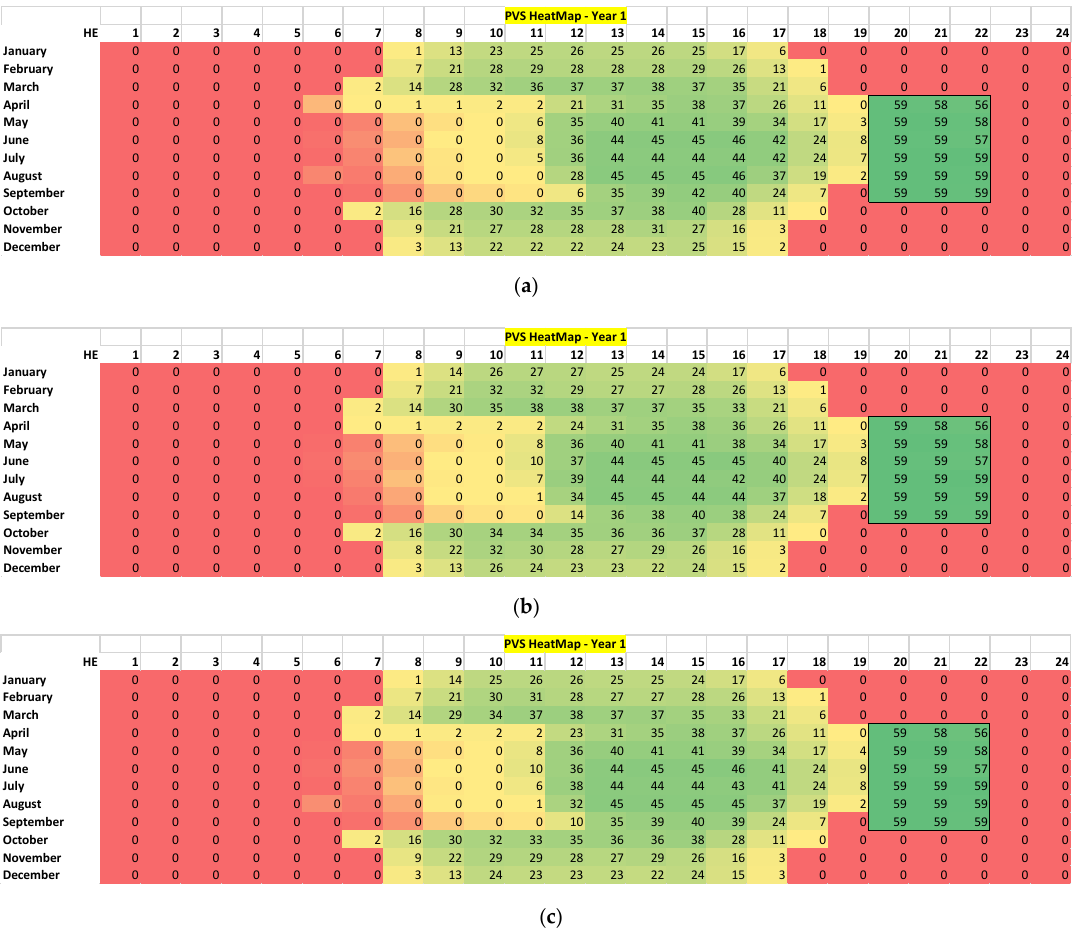
Figure 9. PVS Net Energy Delivered in Year-1 (in MW DC ) Heat Map for the 50 MW AC PV-60 MW/240 MWh BESS system for target period 7–10 p.m. in ( a ) San Bernardino, CA ( b ) San Luis Obispo, CA and ( c ) Sonoma, CA.